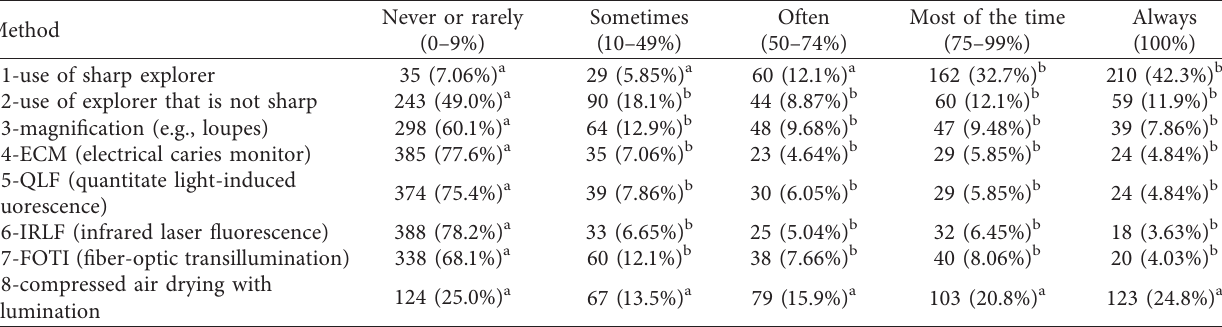
Table 2: Frequency of use of caries detection methods.